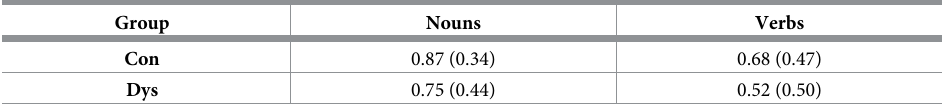
Table 7. Mean accuracy (SDs) of the two groups in nouns and verbs.